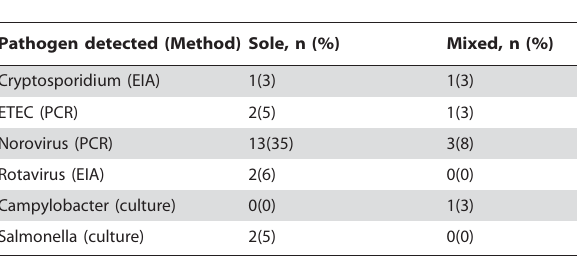
Table 2. Distribution of pathogens identified from stool samples